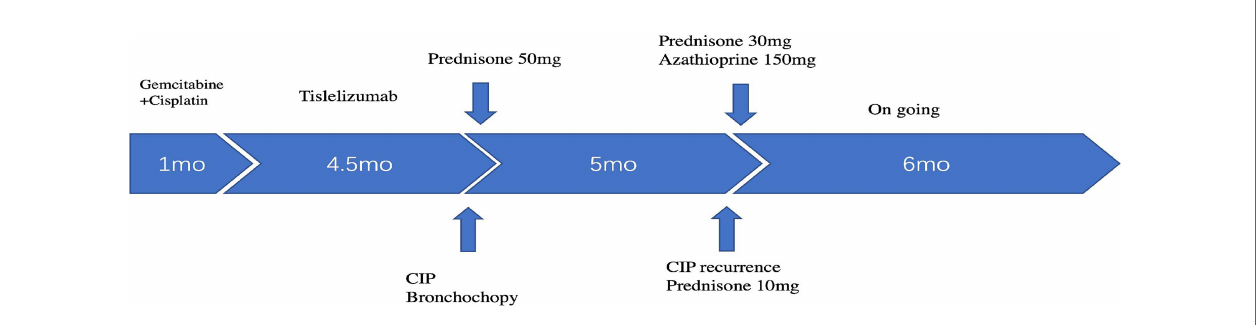
FIGURE 2 | Timeline scheme of major clinical event of the patient since